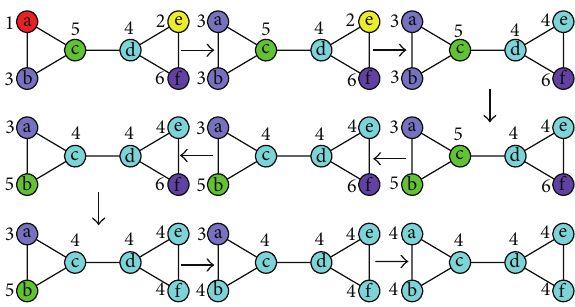
Figure 1: An illustration of monster community